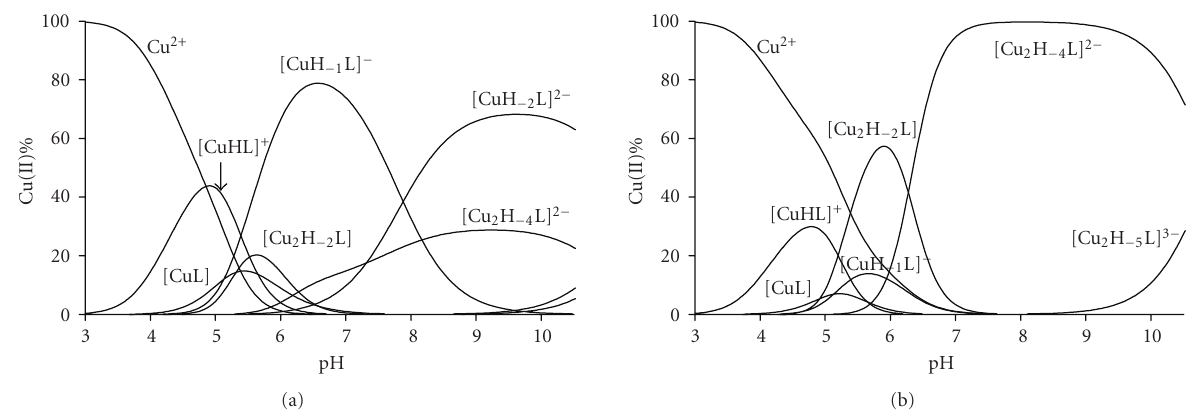
Figure 3: Metal ion speciation of the copper(II)-VIDAH system in (a) equimolar samples and (b) at 2 : 1 metal to ligand ratio, (c L = 2 · 10 − 3 mol/dm 3 ).